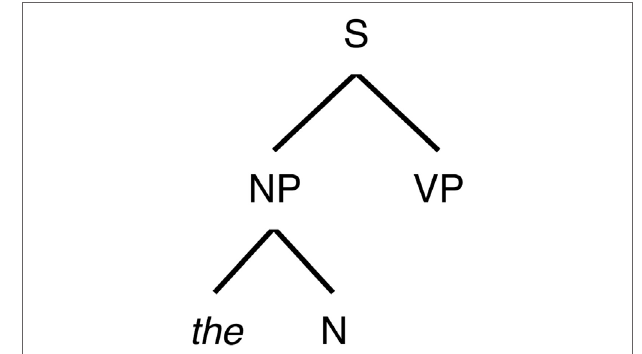
FigURe 3 | A tree structure generated by left corner parsing of the word the from Example (1) by applying rules (c), (b), and (a) consecutively [based on Lewis and Vasishth